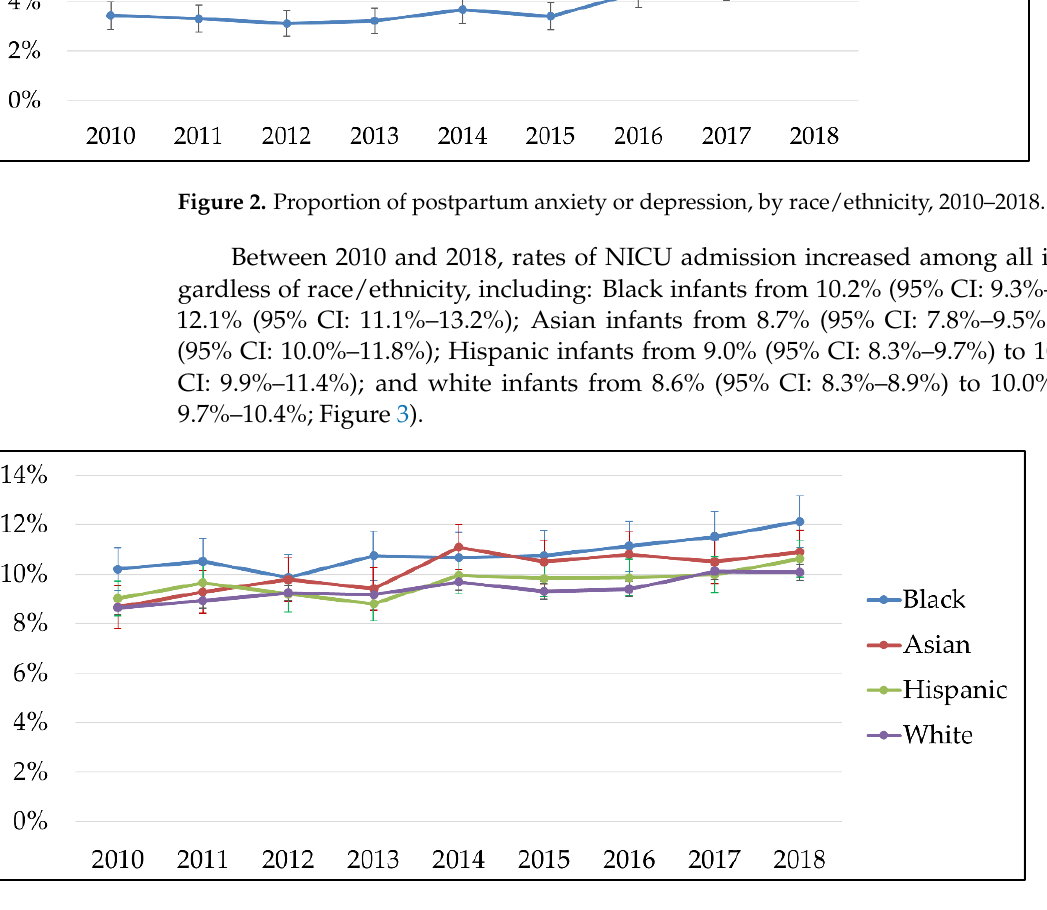
Figure 3. Proportion of NICU newborns, by race/ethnicity, 2010 – 2018. After adjusting for delivery year, age, race/ethnicity, region, insurance, other MH